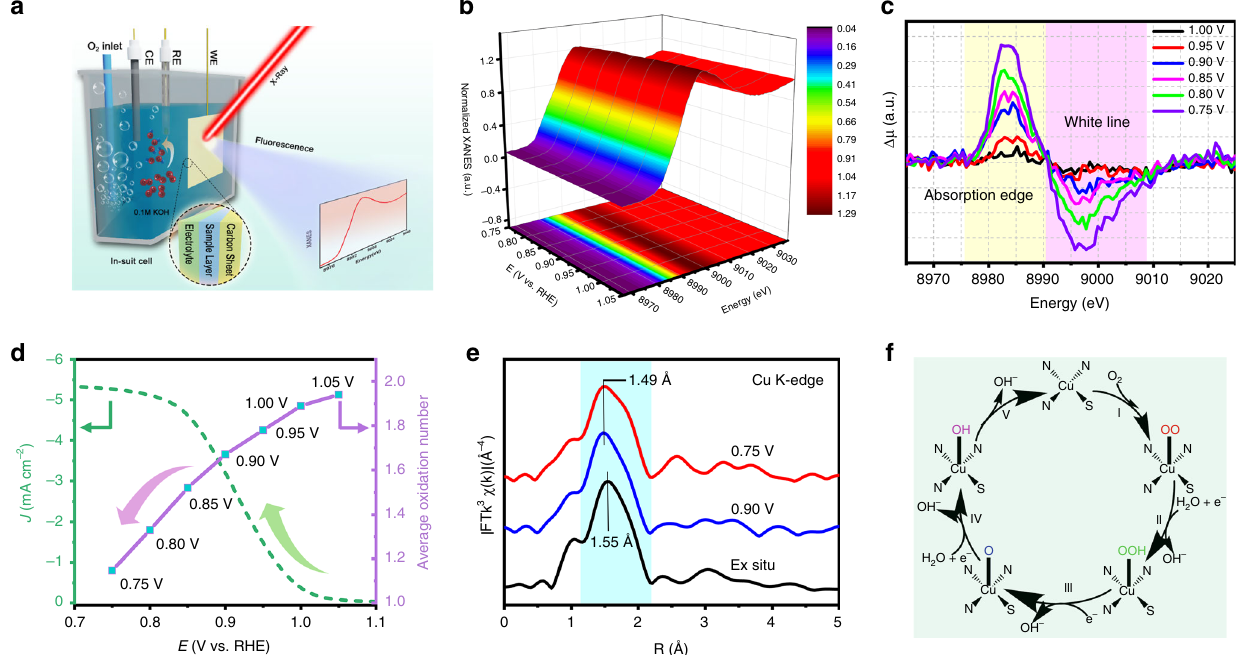
Fig. 4 In situ XAFS characterization of S-Cu-ISA/SNC. a Schematic of the in situ electrochemical cell set-up. CE, counter electrode; WE, working electrode; RE, reference electrode. b Cu K-edge XANES spectra of S-Cu-ISA/SNC at various potentials during ORR catalysis in O 2 -saturated 0.1 M KOH. c Differential Δ µ XANES spectra obtained by subtracting the normalized spectrum at every potential to the spectrum recorded at 1.05 V vs. RHE. d Current density as a function of potential for S-Cu-ISA/SNC (left) and the average oxidation number of Cu species in S-Cu-ISA/SNC as a function of potential (right). e k 3 -weighted FT-EXAFS at ex-situ, 0.90 V and 0.75 V vs. RHE. The shaded region highlighted the variations in the peak position of the fi rst coordination shell. f The proposed ORR mechanism for the